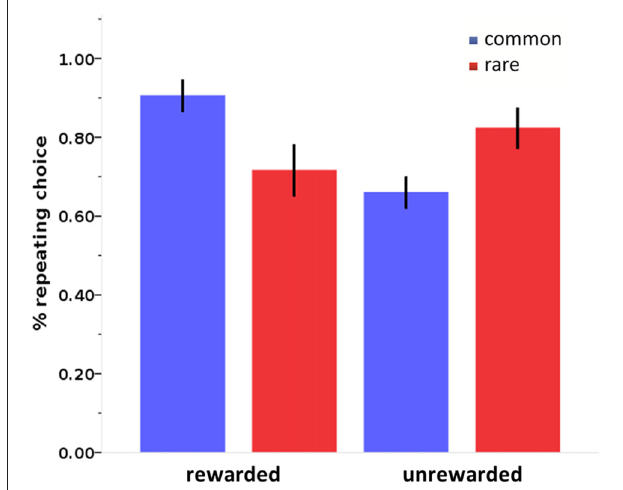
FIGURE 4 | Stay probabilities in the two-step sequential decision-making task. Stay probabilities in the two-step sequential decision-making task show a reward by state interaction. Error bars: 95% confidence